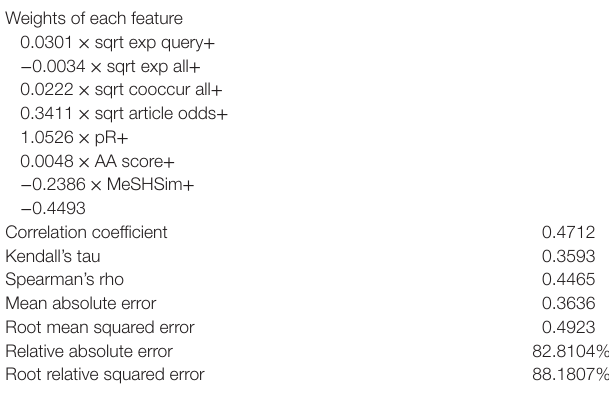
TaBle 5 | Multiple linear regression to predict the number of gap-filling articles appearing in the second time slice in the combined dataset. Weights of each feature 0.0338 × sq exp query +